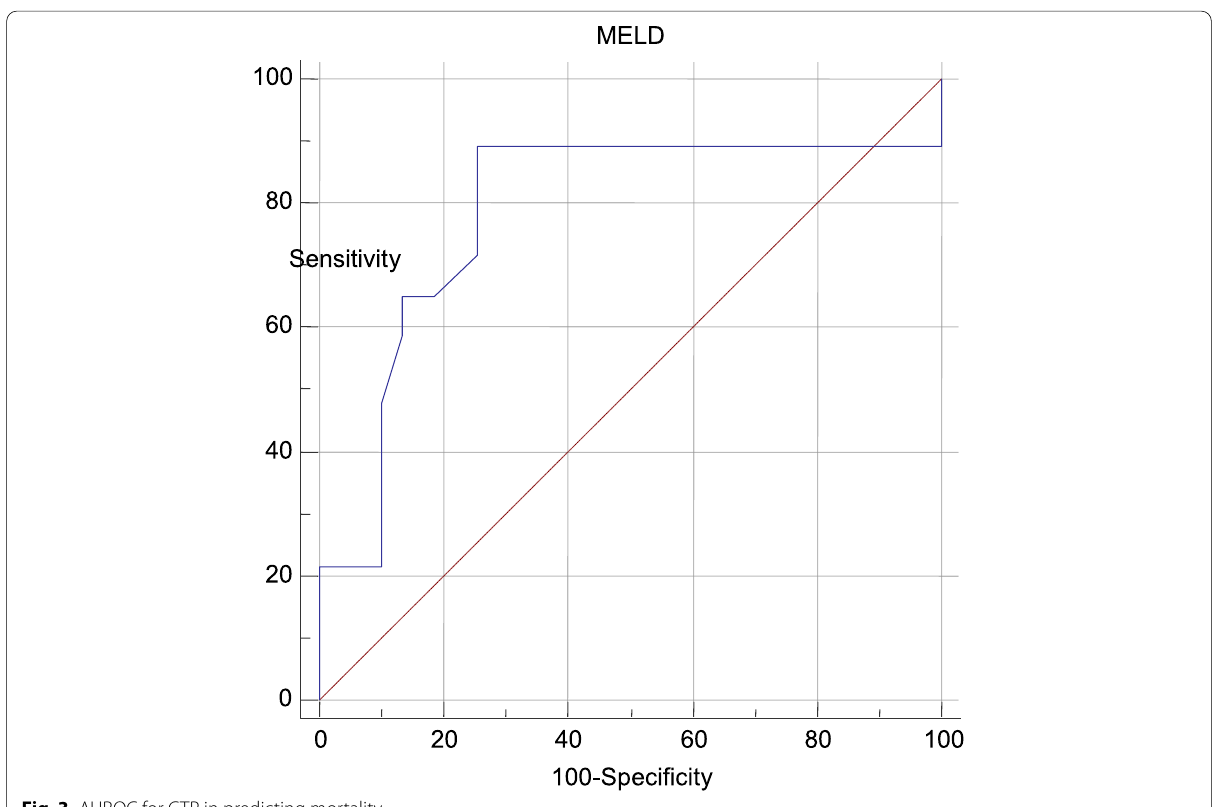
Fig. 3 AUROC for CTP in predicting